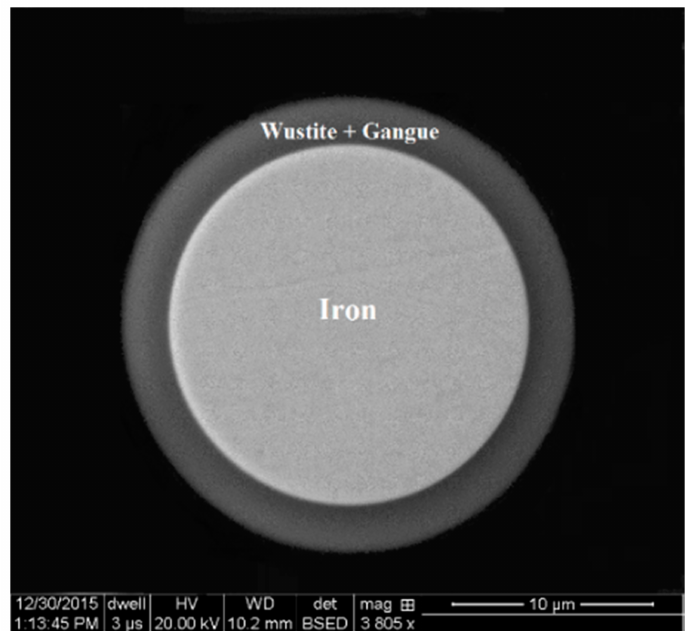
Figure 3. Cross section of a particle reduced to fractional conversion X = 0.94 at 1623 K (1350 ◦ C) (The figure is adapted from [43], with permission from authors,